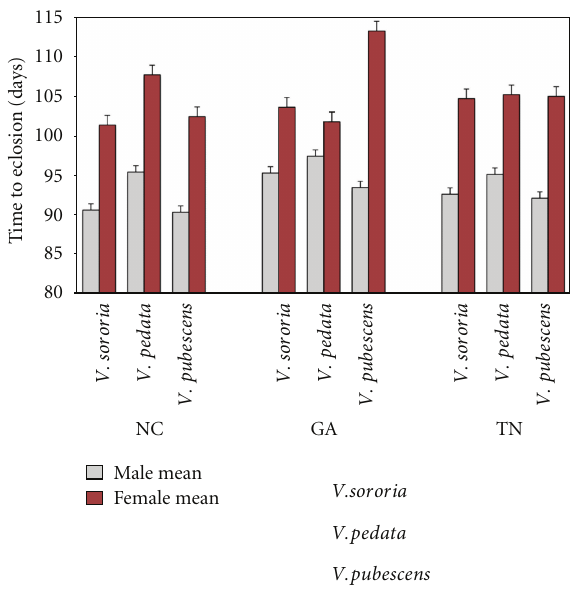
Figure 4: Mean time to eclosion (+/ − SE) for A. diana o ff spring from North Carolina, Georgia, and Tennessee reared on three Southern Appalachian violet ( Viola ) species, V. sororia, V. pedata, and V. pubescens . The only significant di ff erences in time to eclosion was between the sexes ( d f = 1, F = 54 . 11, P = 0 .